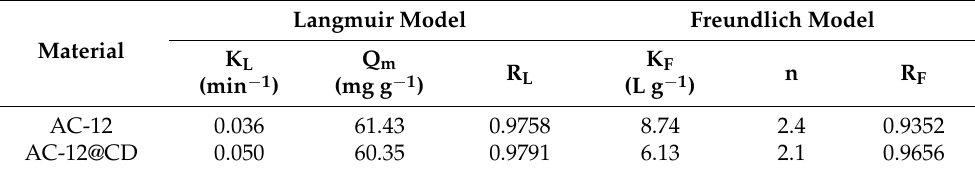
Table 3. Fitting parameters of Langmuir and Freundlich isothermal adsorption models.